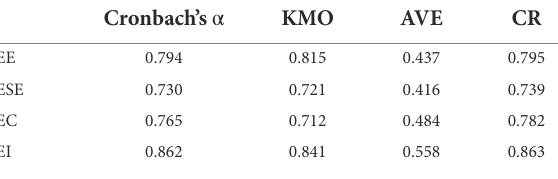
TABLE 3 Reliability test index.